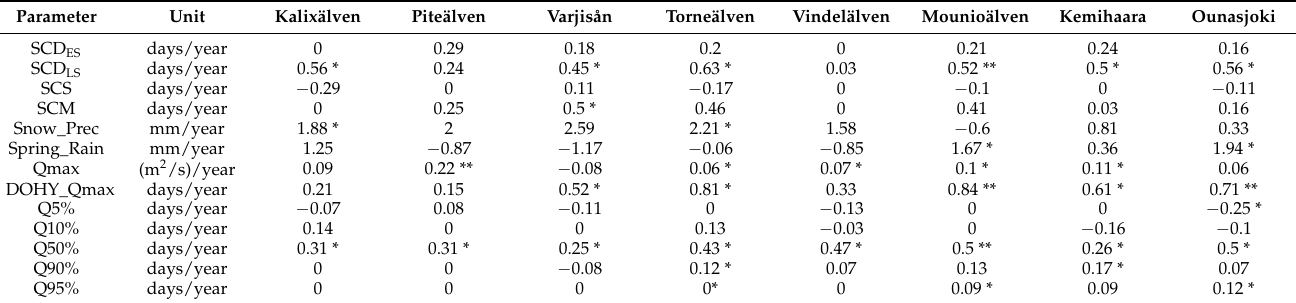
Table 3. Trends resulting from MK tests.